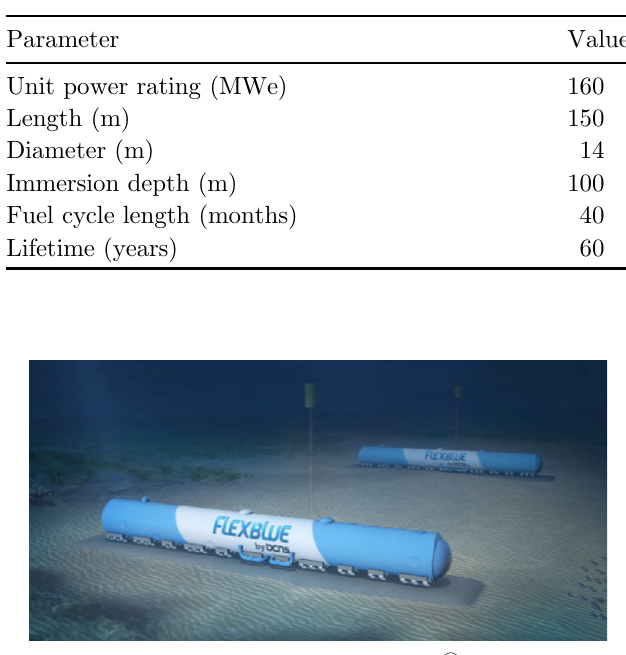
Fig. 1. Artist view of a Flexblue ® farm.